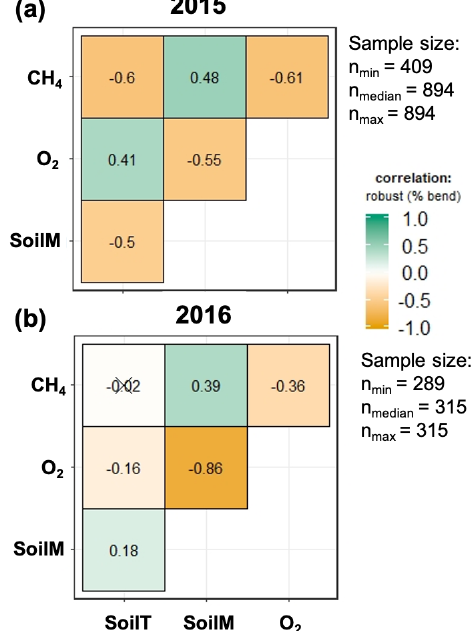
Figure 5. Relation between soil meteorology and methane emis- sions for 2015 (a) and 2016 (b) . SoilM, SoilT, O 2 , and CH 4 rep- resent soil moisture, soil temperature, oxygen, and methane, re- spectively. Numbers represent adjusted Holm correlation coeffi- cients, and numbers with “X” indicate a non-significant correlation at p< 0 .